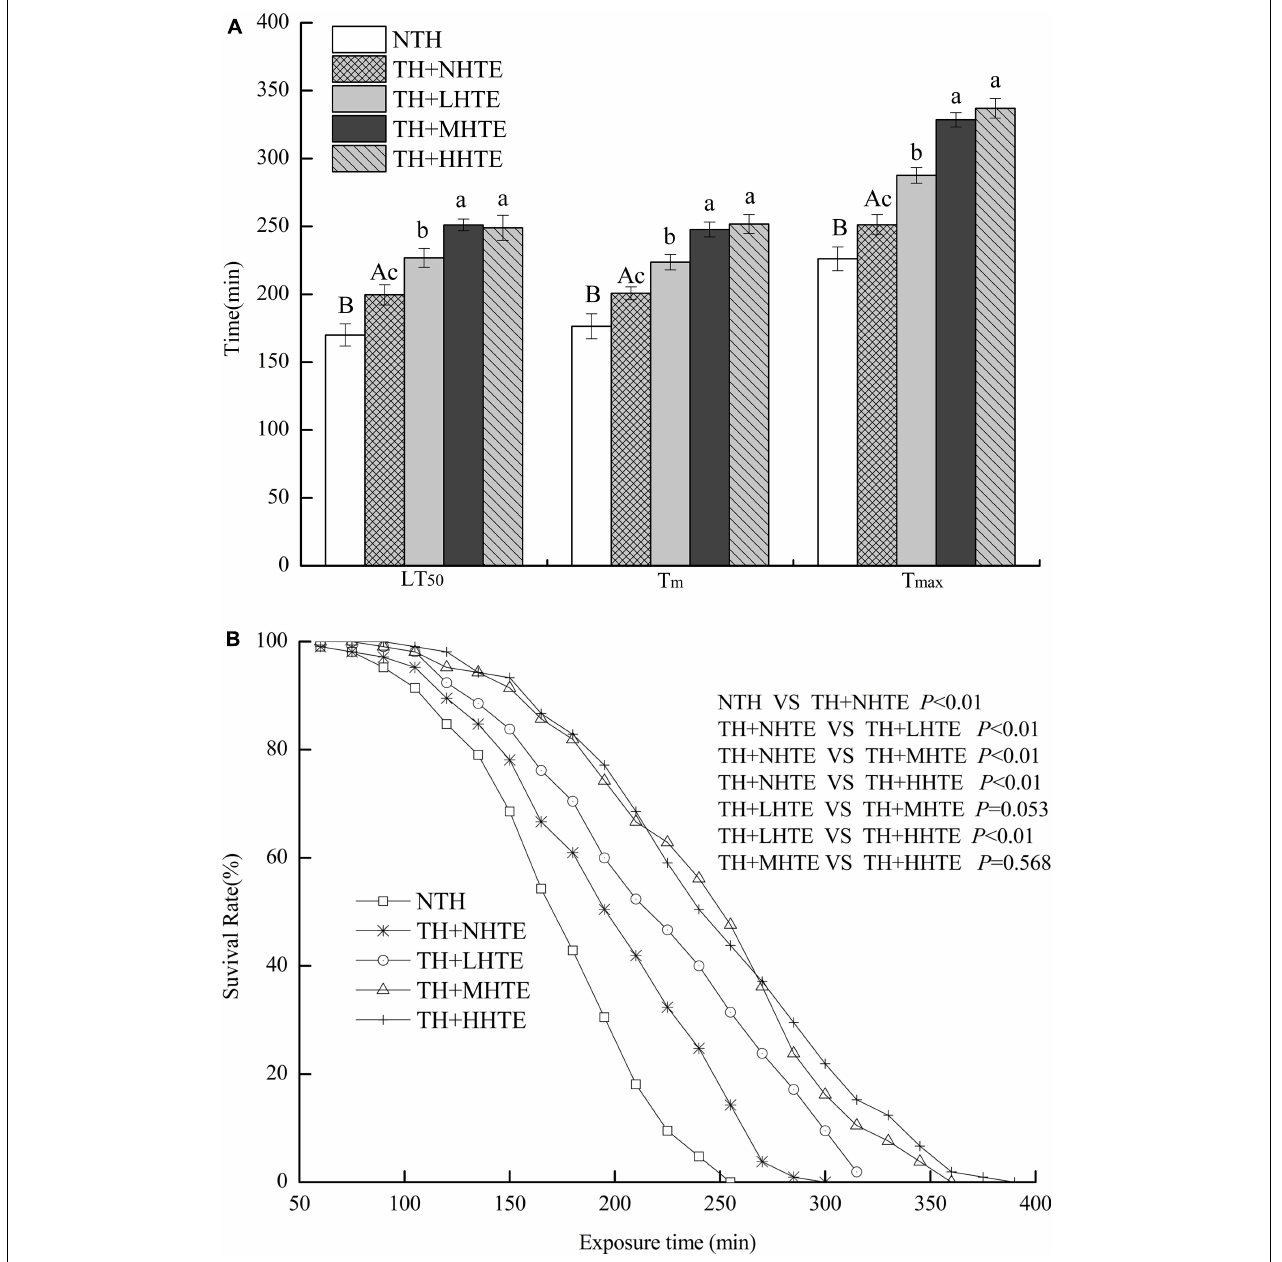
FIGURE 5 | The lethal time of 50% (LT 50 ), mean survival time (T m ), and maximum survival time (T max ) (A) and survival curves (B) of female flies fed a diet containing hsian-tsao extract (HTE) of low, medium, or high concentrations (TH + LHTE, TH + MHTE, or TH + HHTE) with thermal hardening (TH) and a non-HTE control diet with or without TH (TH + NHTE, NTH) (150 female flies per group, 50 per replicate). Data show mean ± SD. Different uppercase letters indicate significant differences between NTH and TH + NHTE, while different lowercase letters indicate significant differences between groups with thermal hardening (LSD test after one-way ANOVA, P <